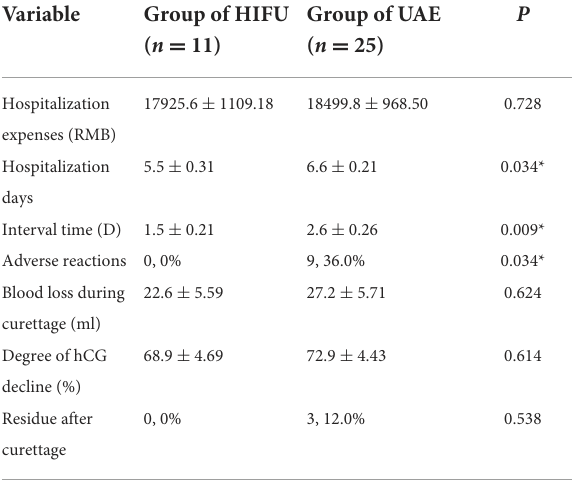
TABLE 3 Comparison of prognosis between HIFU and UAE